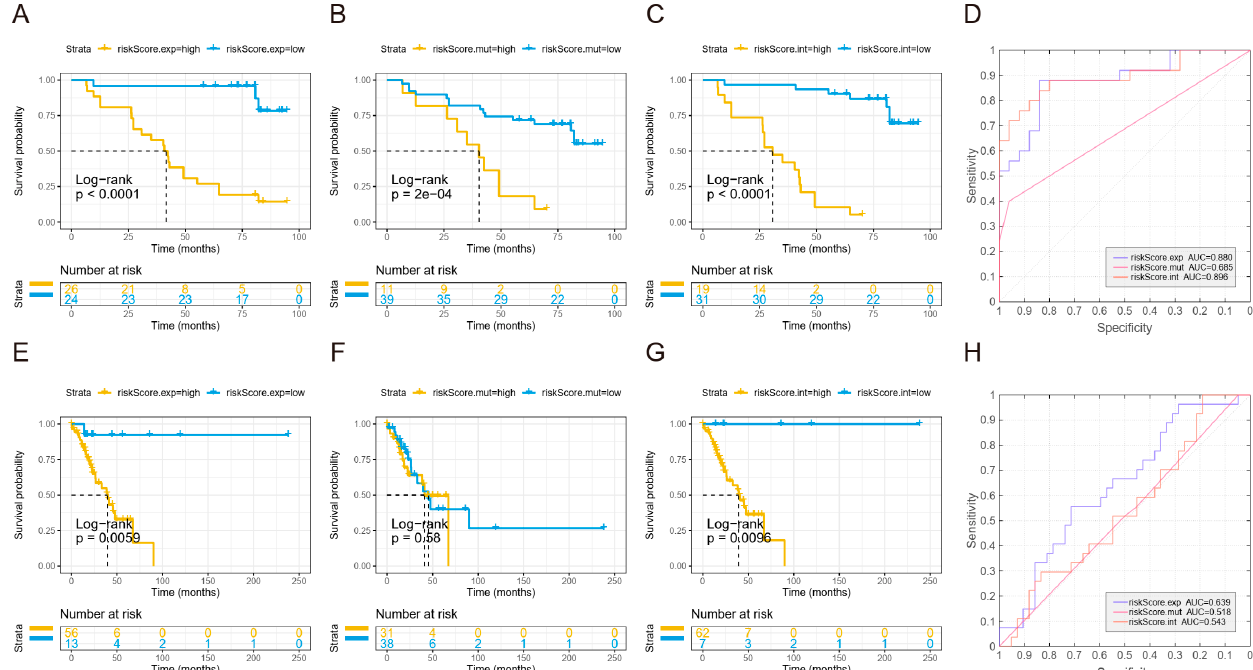
Figure 5. Establishing a prognostic model for predicting recurrence of stage I NSCLC. ( A – C ) Kaplan–Meier curve for DFS of high-risk group and low-risk groups according to expression risk score ( A ), mutation risk score ( B ), and integration risk score ( C ) calculated in the test cohort. ( D ) ROC curve for each risk score calculated in the test cohort. ( E – G ) Kaplan–Meier curve for DFS of high-risk group and low-risk groups according to expression risk score ( E ), mutation risk score ( F ), and integration risk score ( G ) calculated in the TCGA validation cohort. ( H ) ROC curve for each risk score calculated in the TCGA validation cohort. The cutoff values in the Kaplan–Meier plots were determined by a result-oriented function “surv_cutpoint” in survminer package.